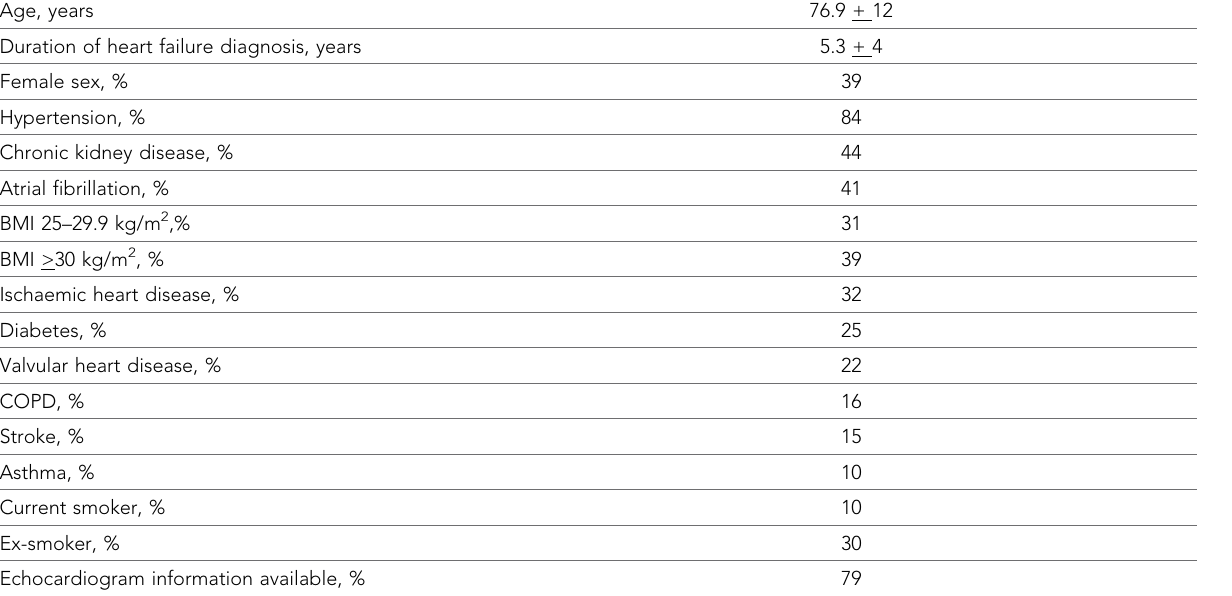
Table 1. Characteristics of